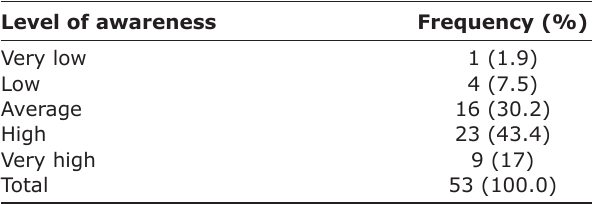
Table-2: Respondents’ levels of awareness about OH approach.